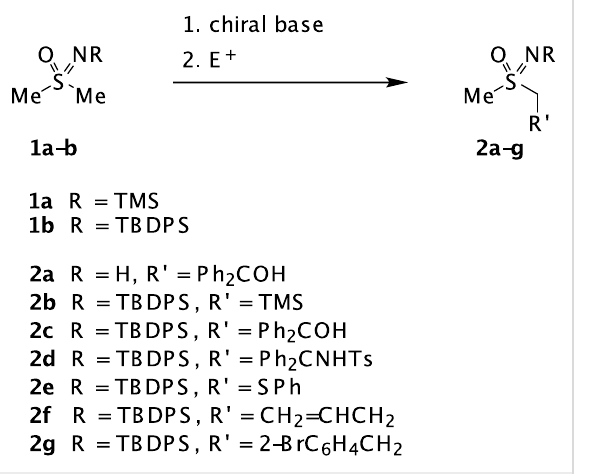
Scheme 1: Desymmetrisation of N -trialkylsilyldimethylsulfoximines using chiral bases